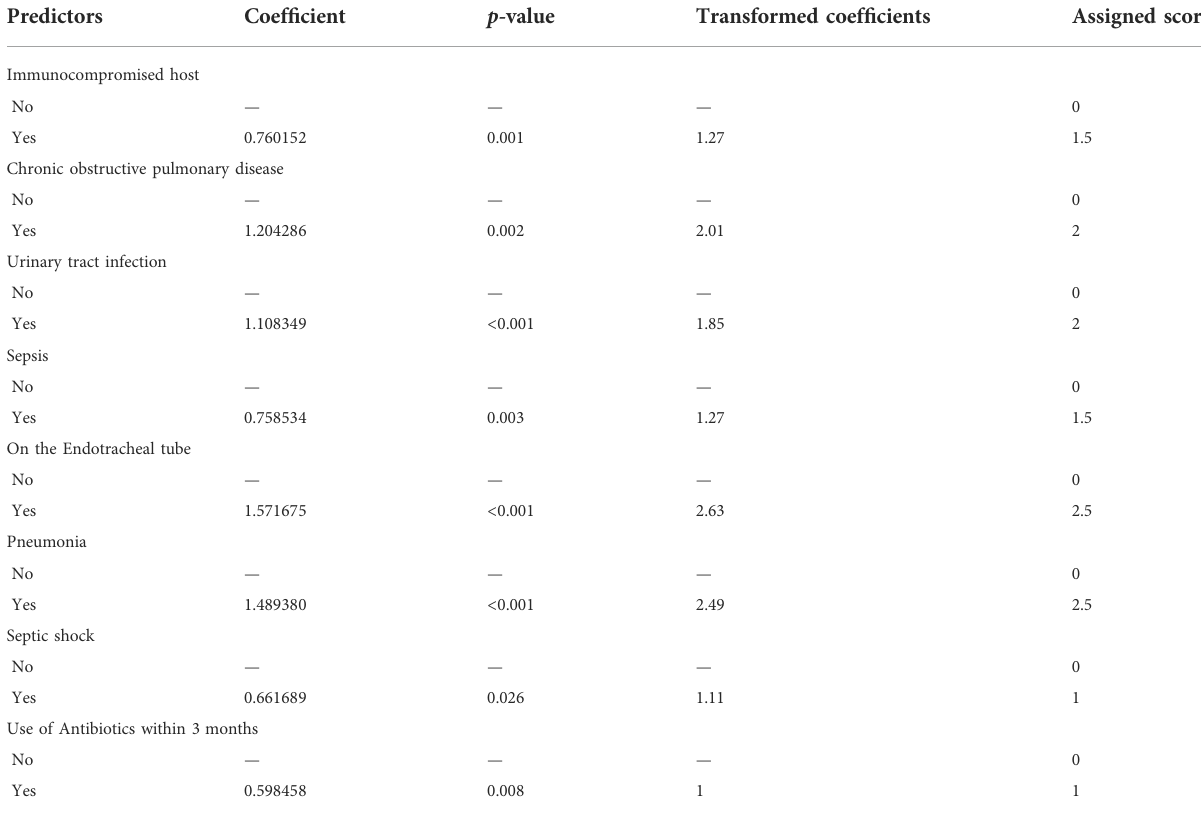
TABLE 3 | Signi fi cant factors of mortality in patients with MDROs using multivariable analysis (ICU-SEPSA